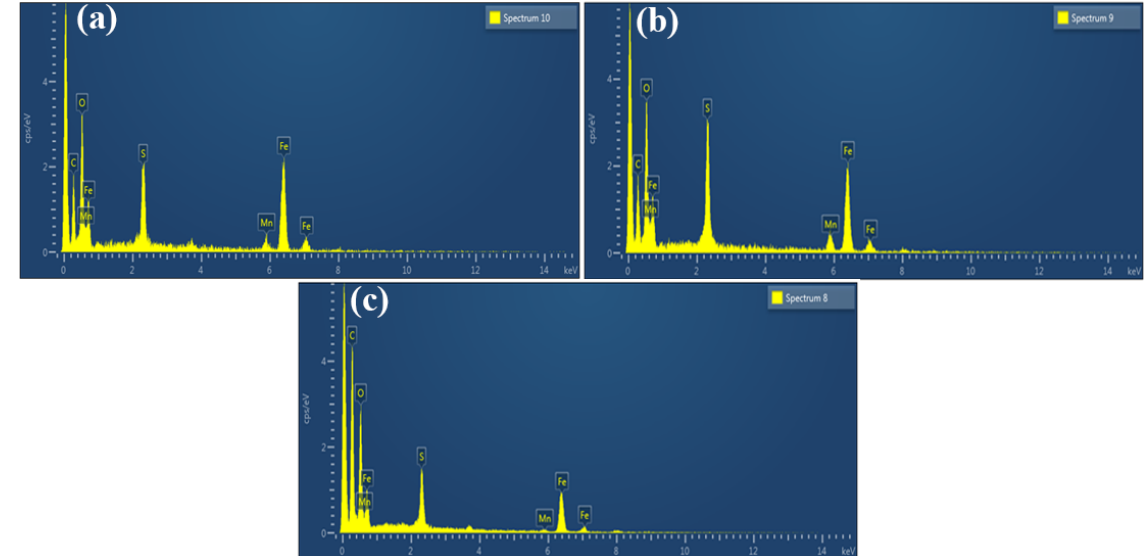
Figure 3. EDX spectrum of ( a ) 3%S@Mn(Fe 2 O 4 ), ( b ) 0.05%S@Mn(Fe 2 O 4 ), and ( c ) 0.07%S@Mn(Fe 2 O 4 ).